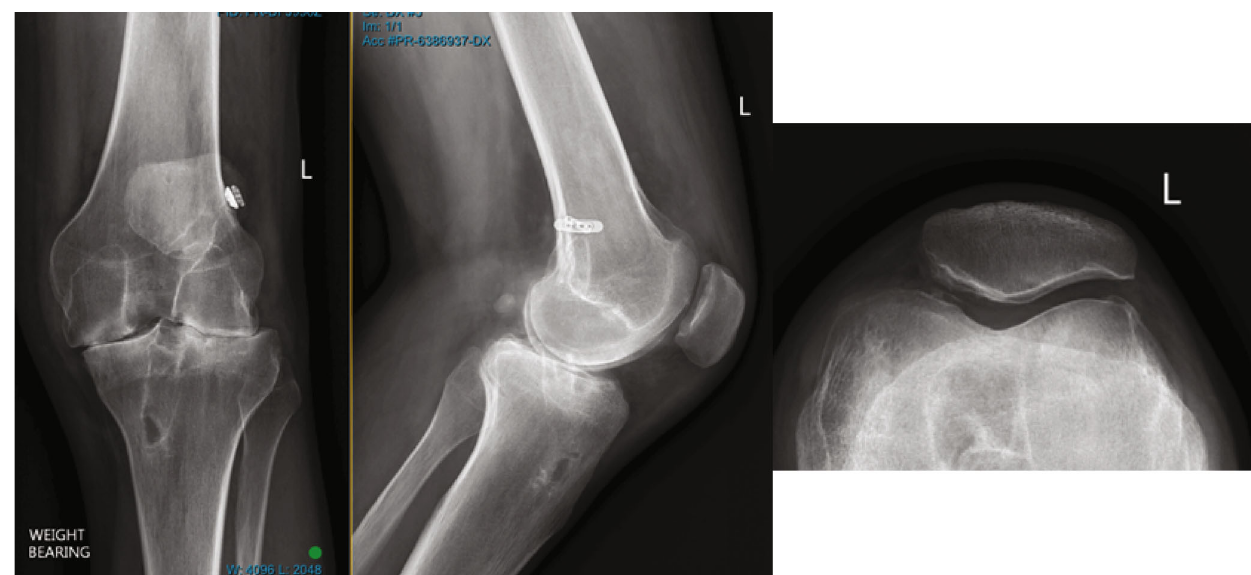
Figure 3: Radiograph in 2019 of BP ’ s left knee. Note the signi fi cant interval change from 2016